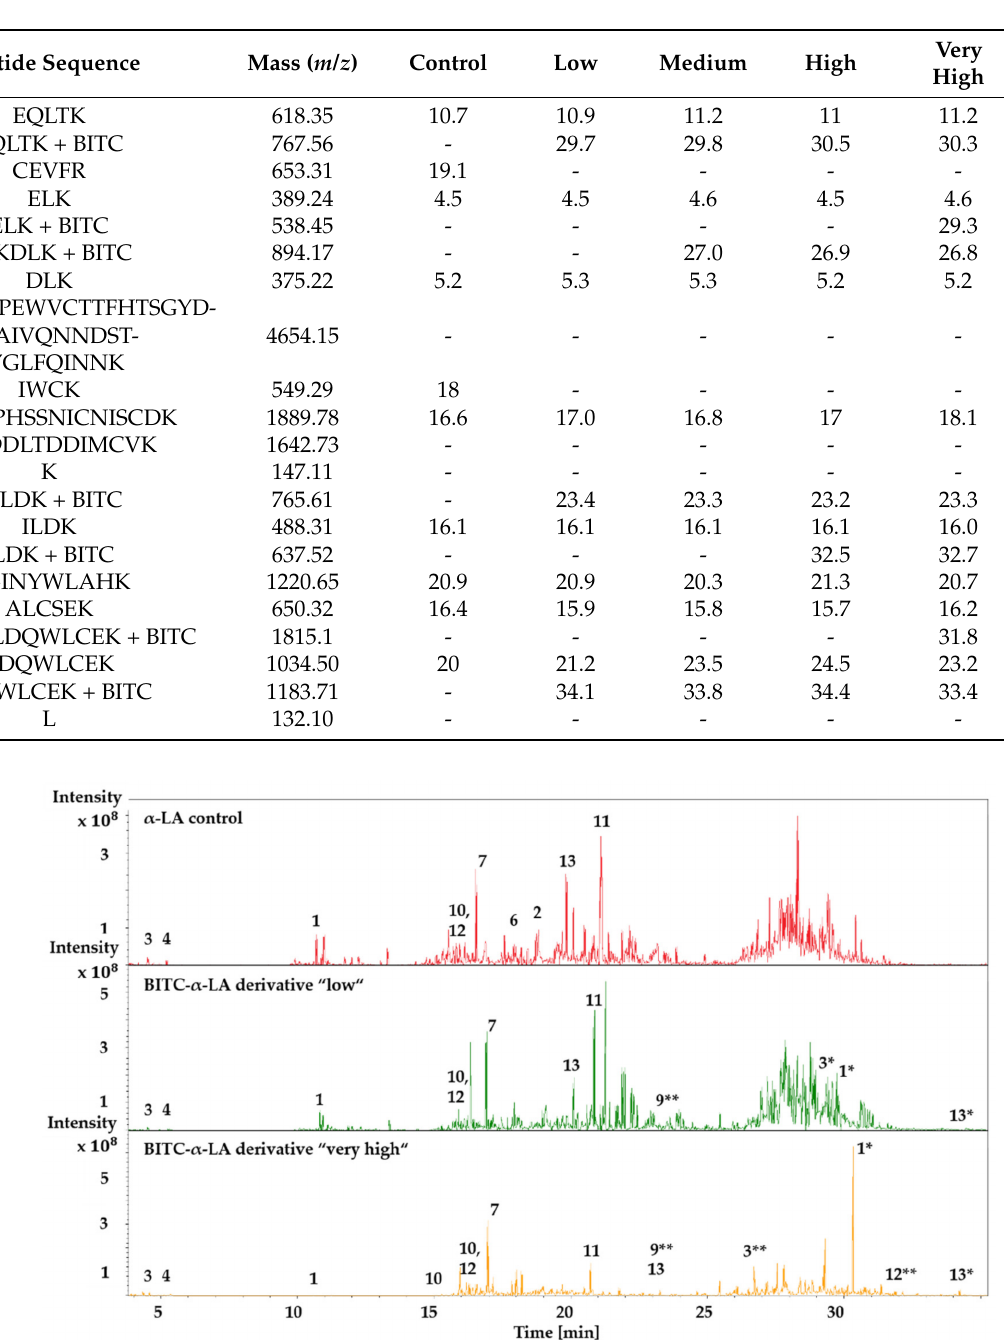
Table 4. Summary of all identified peptides after tryptic hydrolysis of the unmodified control sample (K) and BITC- α -LA derivatives. The numbering, the corresponding peptide mass, and the associated retention time are listed. Peptides that have been modified are marked with an “*”, while elongated peptides resulting from BITC modification were highlighted with “**”.